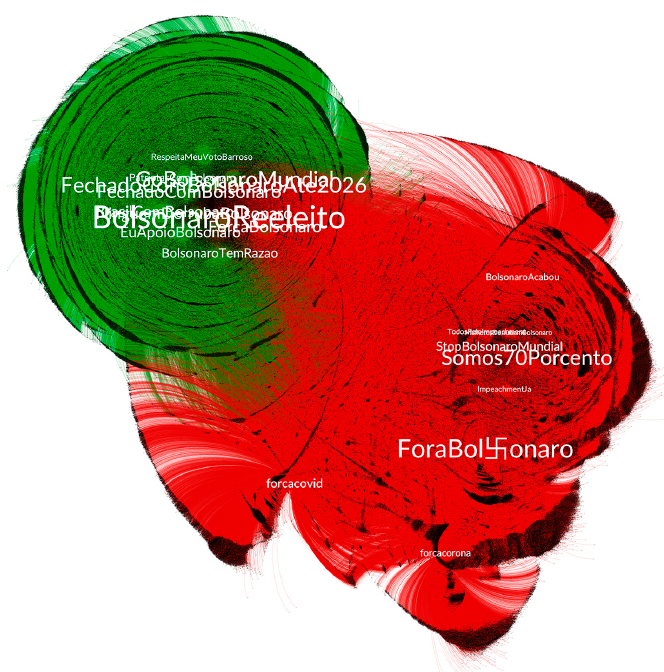
Figure 4. Relational data of